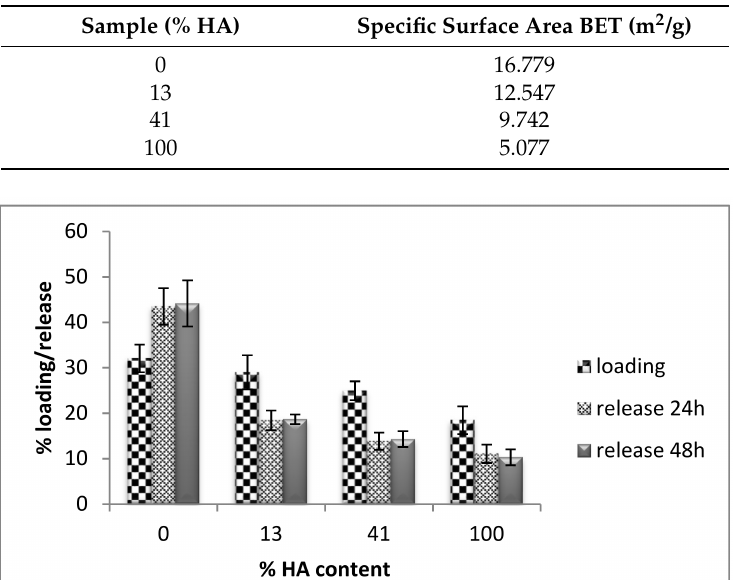
Table 1. Specific surface area of HA, β -TCP and biphasic calcium phosphate powders.